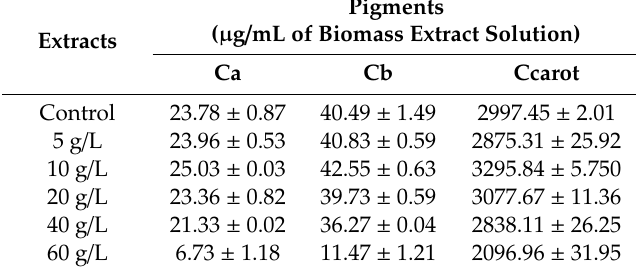
Table 1. Chlorophyll a (Ca), chlorophyll b (Cb), and carotenoid (Ccarot) contents of Scenedesmus sp. extract solution cultured under di ff erent salt concentrations (g / L). Control: Scenedesmus sp. cultured in Modified Detmer’s Medium (MDM) without salt. The processed microalgae biomass was 60 mg dry weight.